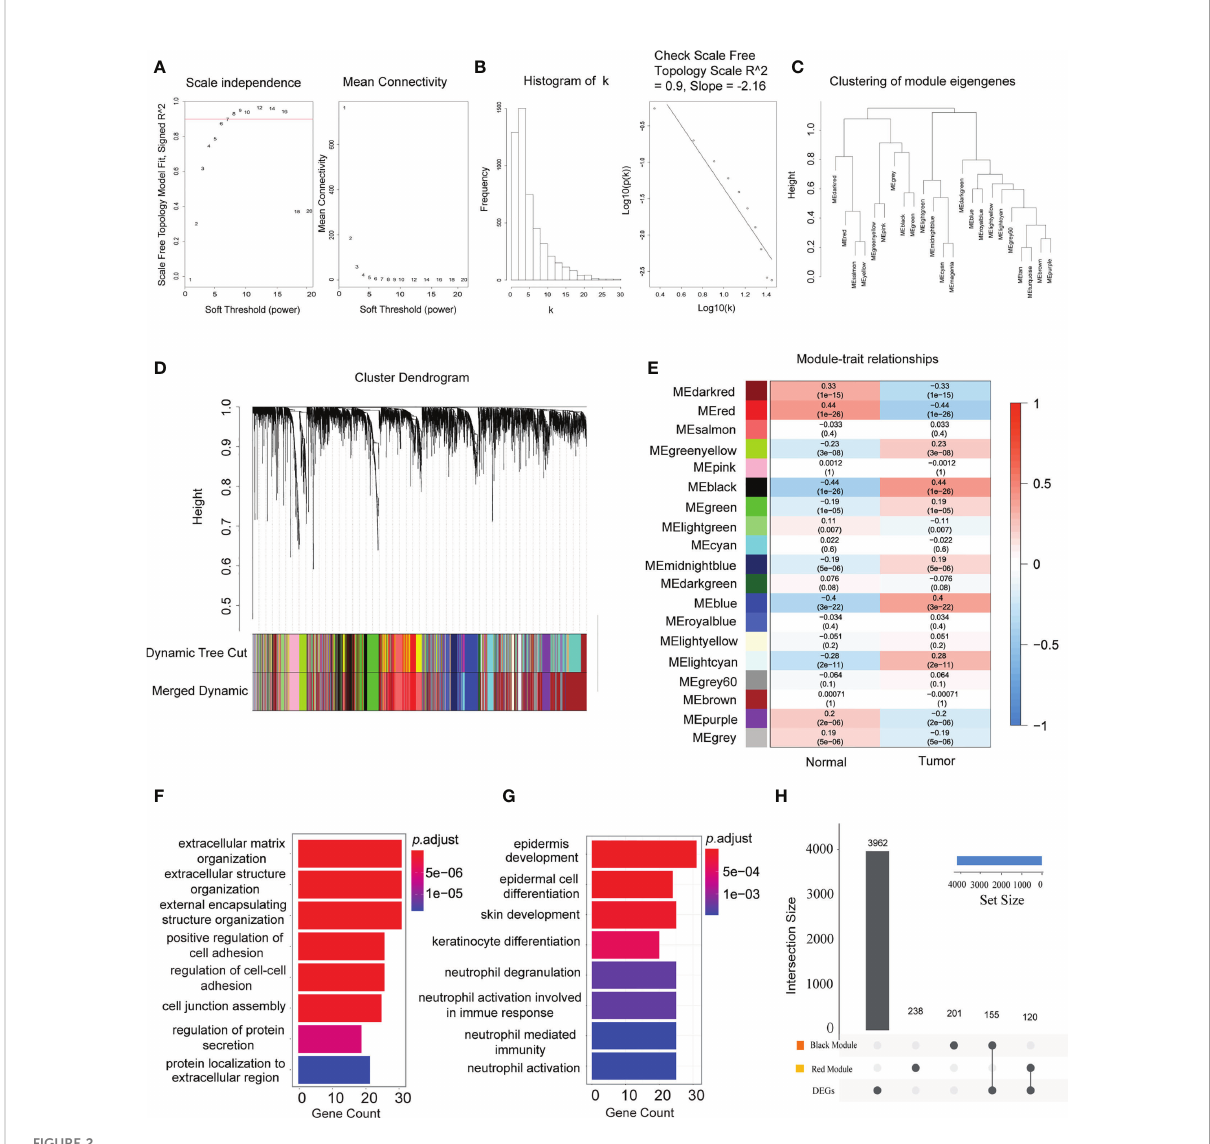
FIGURE 2 Establishment of the co-expression network modules for the occurrence and progression of head and neck squamous cell carcinoma (HNSCC). (A) Scale independence and mean connectivity of the network in different statistical thresholds. The panel displays the strong correlation of the statistical thresholds with a scale-free fi t index. (B) Robust in fl uence of the statistical threshold on mean connectivity. (C) Clustering of the eigengene modules by weighted gene co-expression network analysis (WGCNA) and their correlation with the occurrence and progression of HNSCC. (D) Cluster dendrogram based on the dissimilarity of the topological overlap matrix. Different colours correspond to the co-expression modules in HNSCC. (E) Heatmap of the correlation between the identi fi ed modules and clinical features ( n = 44 in normal tissues and n = 502 in tumor tissues). The x -axis corresponds to the clinical features, while the y -axis represents the identi fi ed modules. The colour scale ( blue to red ) indicates correlation. Data are presented as the correlation coef fi cient in the top row and the p -value in the bottom row in parentheses . (F) Signi fi cant enriched Gene Ontology (GO) biological process terms for the HNSCC positively associated ( black ) module. (G) Signi fi cant enriched GO biological process terms for the HNSCC negatively associated ( red ) module. (H) Intersection of the differentially expressed genes in the different modules. Bar charts indicate the number of involved genes in the black or red